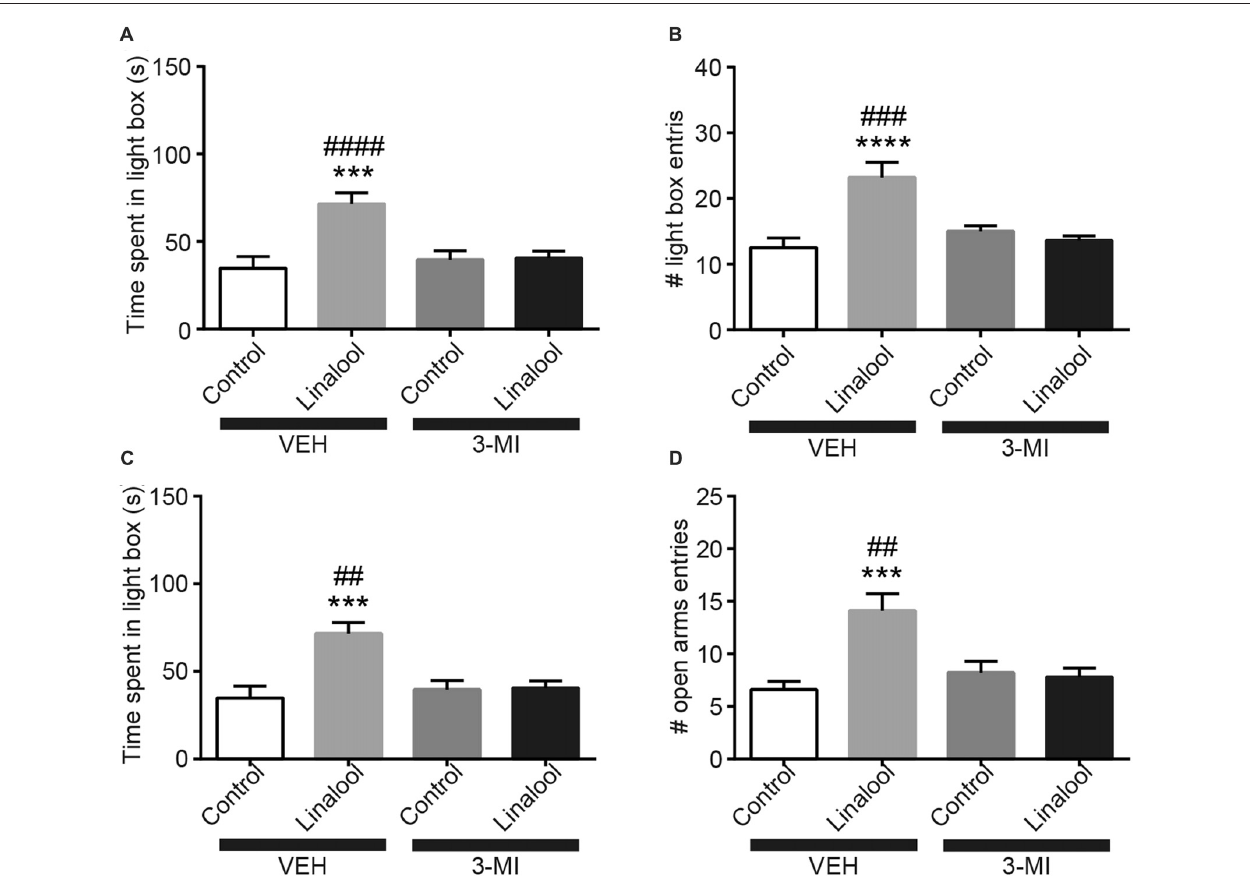
FIGURE 3 | Olfactory input was essential for the anxiolytic effects induced by linalool exposure. The increase in time spent in light box (A) and in number of entries to light box (B) by linalool odor exposure were not observed in anosmic mice resulting from treatment with 3-methylindole (3-MI). The increase in time spent in open arms (C) and number of entries to open arms (D) were not observed in the anosmic mice. Control, mice exposed to odorless air; Linalool, mice exposed to 200 µ L of linalool; VEH, mice administered vehicle (corn oil, i.p.); 3-MI, mice administered 3-MI (300 mg/kg, i.p.); n = 10 for all groups; each column represents mean ± SEM. ∗∗∗ P < 0.001, ∗∗∗∗ P < 0.0001 compared to the vehicle injected Control group, ## P < 0.01, ### P < 0.001, #### P < 0.0001 compared to the 3-MI injected Linalool group ( post hoc Tukey’s multiple comparison